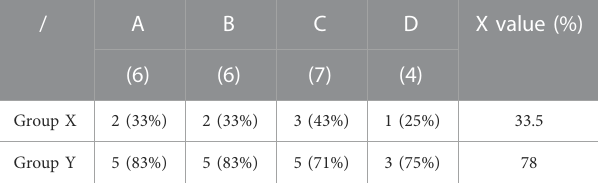
TABLE 2 Analysis of the relationship between groups X and Y and the four driver genes.